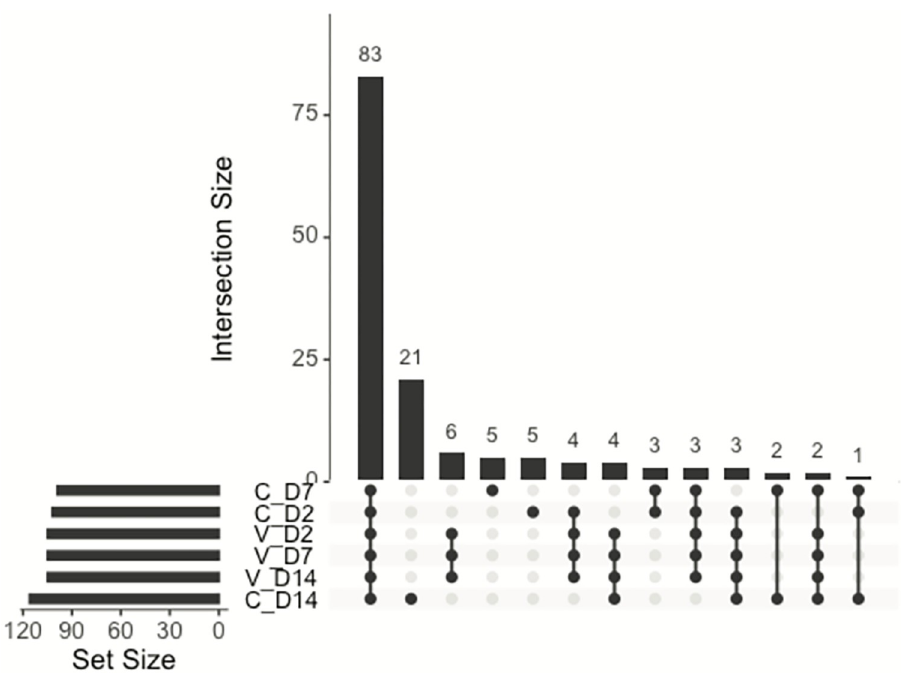
Fig 5. The top histogram represents the number of miRNAs shared between treatments (intersection size), and each row below the histogram represents a treatment. The lines connecting treatments below the top histogram represent treatments which share that number of miRNAs, and the histogram to the side of the treatments represents the number of miRNAs contained within each treatment. V denotes a viral sample, C denotes a control, D2, D7, and D14 represent 2, 7, and 14 dpi